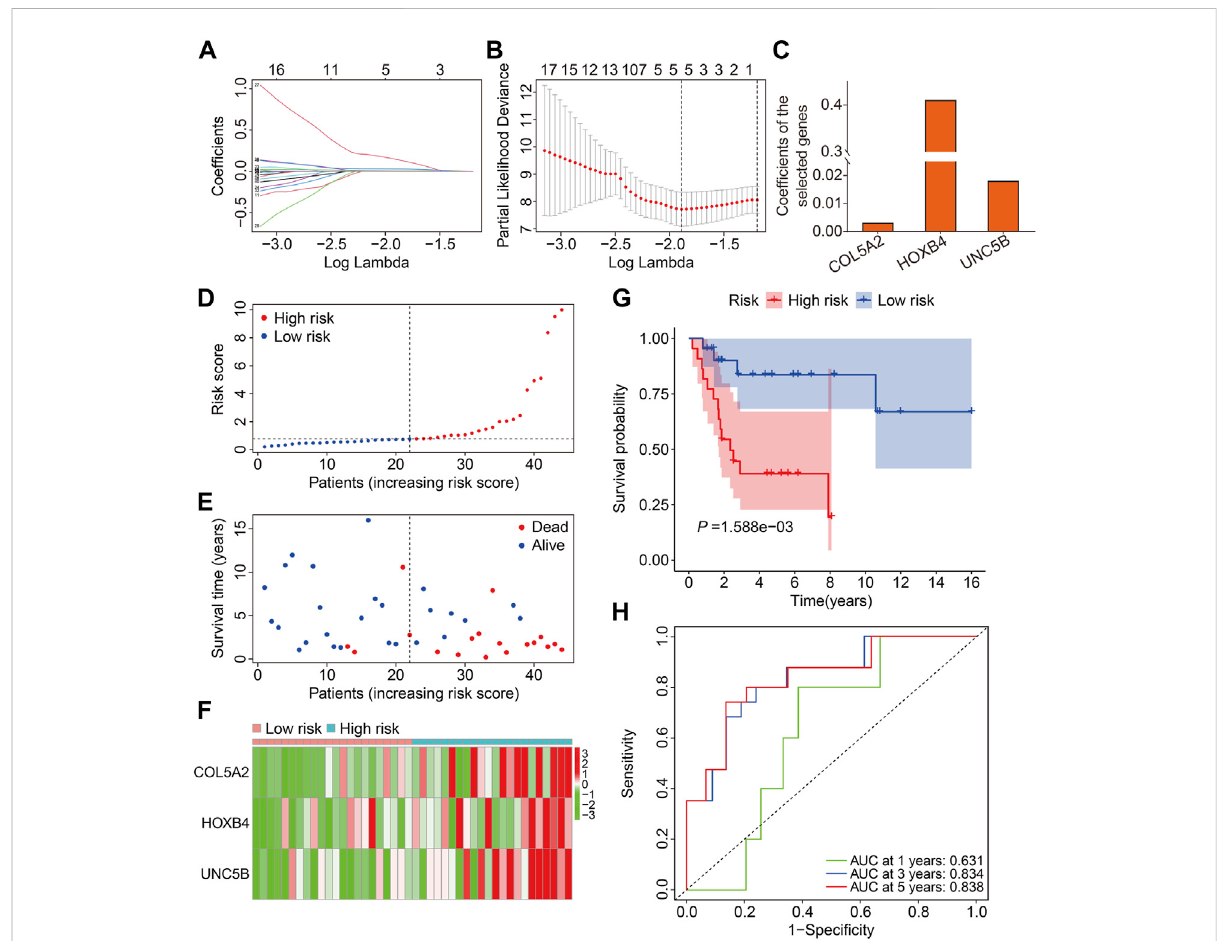
FIGURE 3 Constructionofaprognosticsignatureinosteosarcomabasedonferroptosis-associatedgenesintheturquoisemodule. (A,B) Lasso regression and multivariable Cox regression analyses were performed. (C) Regression coef fi cients of the three FAGs. (D – F) Risk score distribution, vital status, survivaltimedistribution,andexpressionpro fi lesofthethreeFAGsinhigh-andlow-riskgroups. (G) Kaplan – Meiersurvivalanalysiscomparingoverall survival between the risk groups. (H) Time-dependent ROC curves for 2-, 3-, and 5-year survival